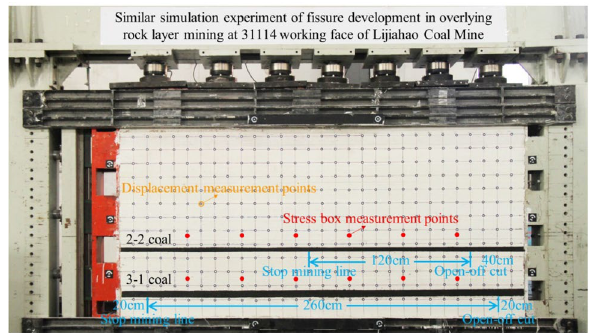
Figure 1. Model laying object.